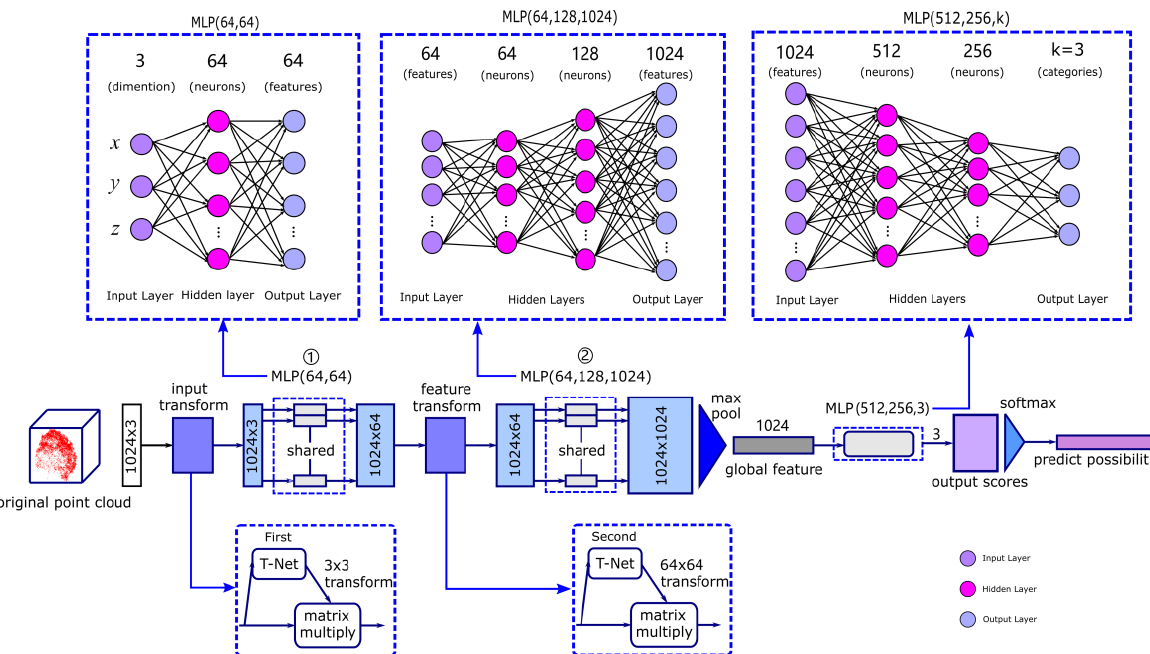
Figure 4. The architecture of PointNet. The architecture is mainly composed of two transformation matrix prediction networks (T-Net), three multi-layer perceptrons (MLP) and a max pooling layer. The network takes 1024 points in a voxel as input, applies input and feature transformations, and then aggregates point features by max pooling. The output is the predicted possibilities for the classifications of classes.